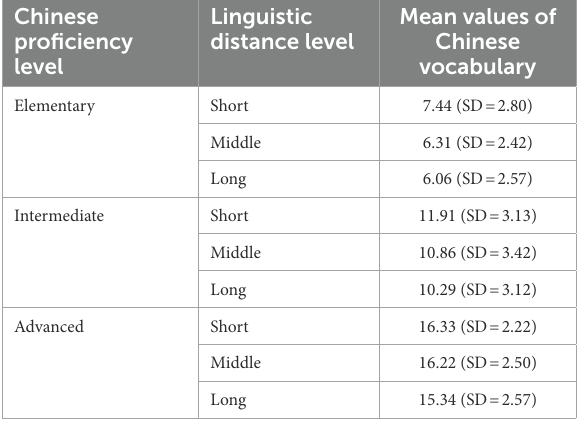
TABLE 3 Chinese vocabulary test score descriptive